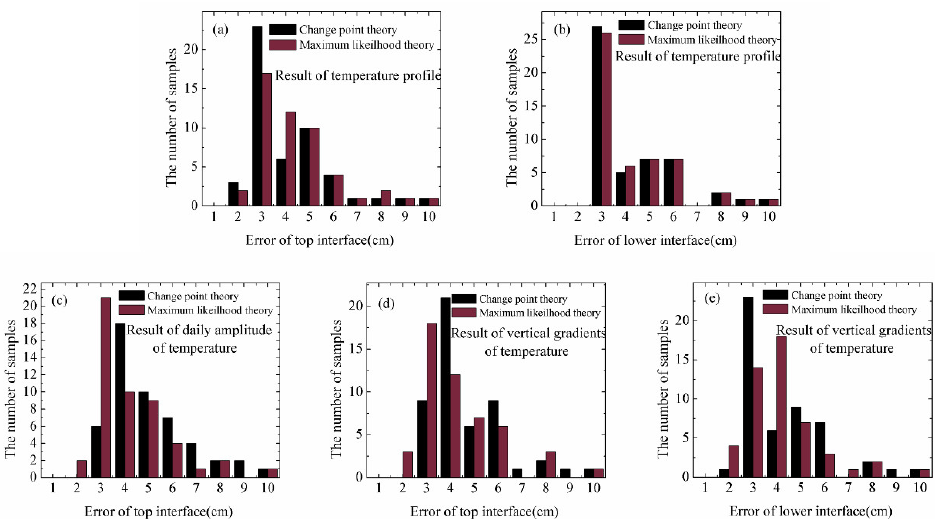
Figure 8. The statistical errors of snow depth (top interface) and ice thickness (lower interface) of the change point detection method and maximum likelihood detection method using temperature profiles ( a , b ), daily change of temperature ( c ), and vertical gradients of temperature ( d , e ). Table 2. Results of the two methods.